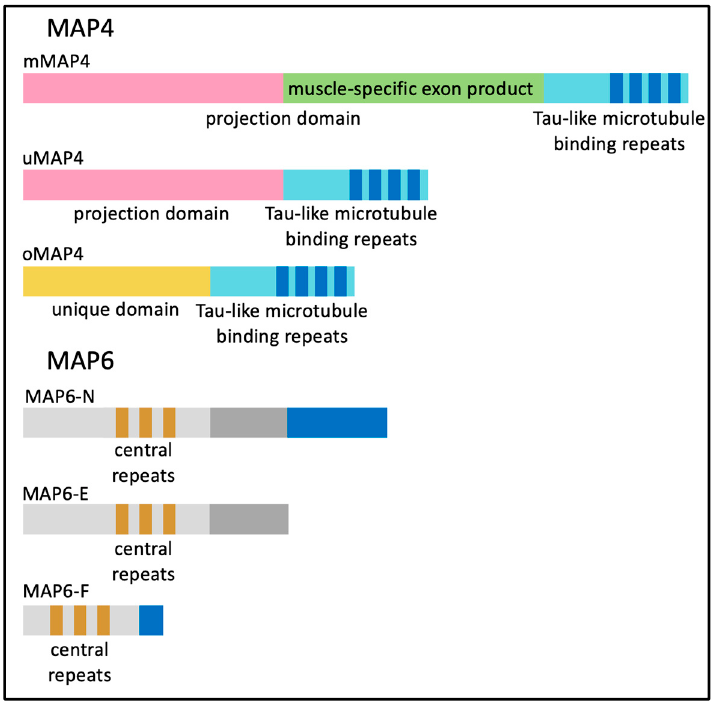
Figure 5. The protein domains of different isoforms of MAP4 and MAP6.